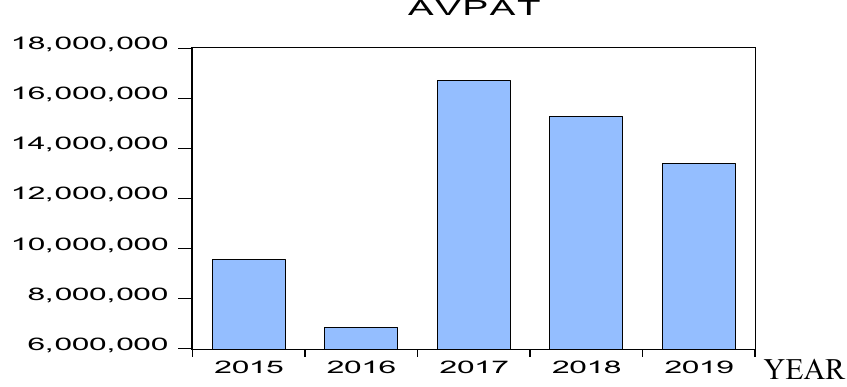
Fig. 3. Trend of profit after tax (Computed by the researchers in E-views